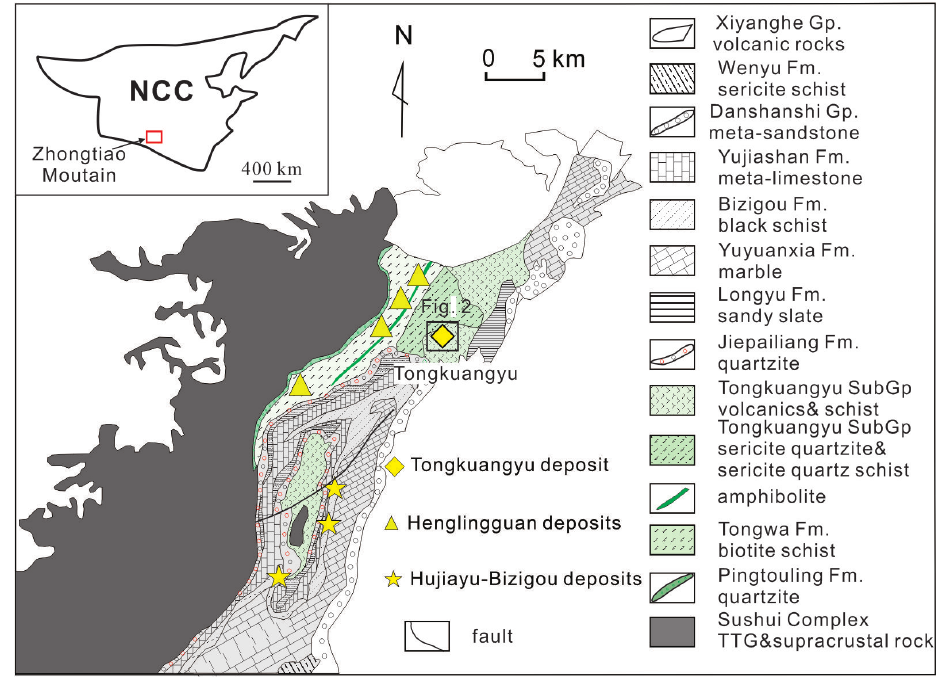
Figure 1. Geological map of the Zhongtiao mountain with an inset showing its location in the North China Craton (NCC) (adapted from Liu et al.